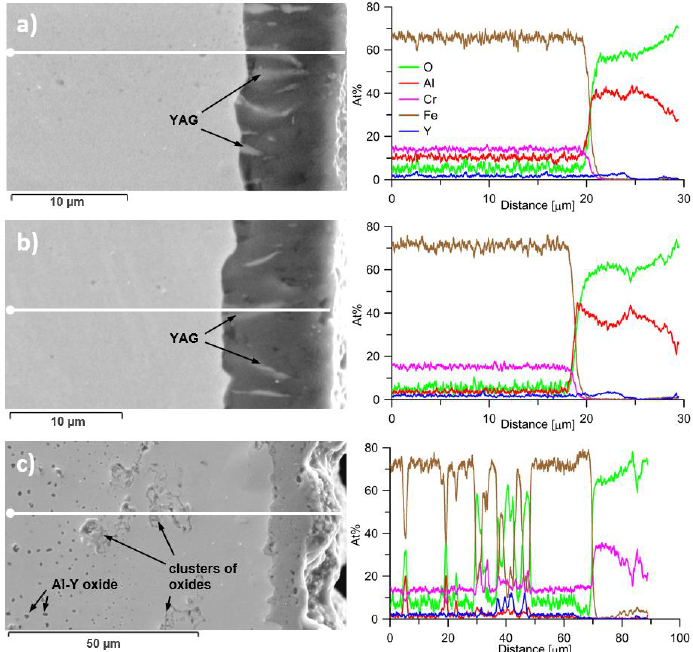
Figure 7. Scanning electron microscopy (SEM) analysis of the cross-sections of the oxide scales of grades ( a ) A1; ( b ) A2; ( c ) A3 after the exposure for 64 h/1200 °C completed with the energy dispersive spectrometer (EDS) line